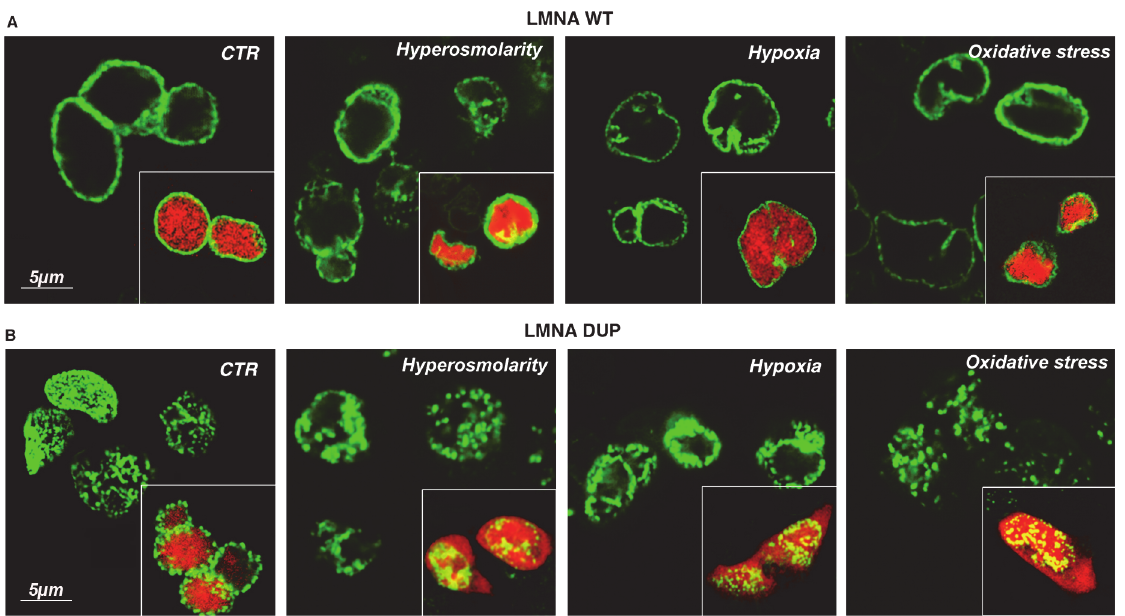
Fig 5. Analysis of nuclear envelope integrity under stressing condition in LMNA transfected HL-1 cells. Nuclear WT LMNA (A) and DUP LMNA (B) signals in control (CTR) and stressing conditions (Hyperosmolarity, Hypoxia, Oxidative stress). The merged signals of LMNA proteins and the RFP nuclear marker are shown in the insets. Confocal XY planar projections are depicted in each experimental